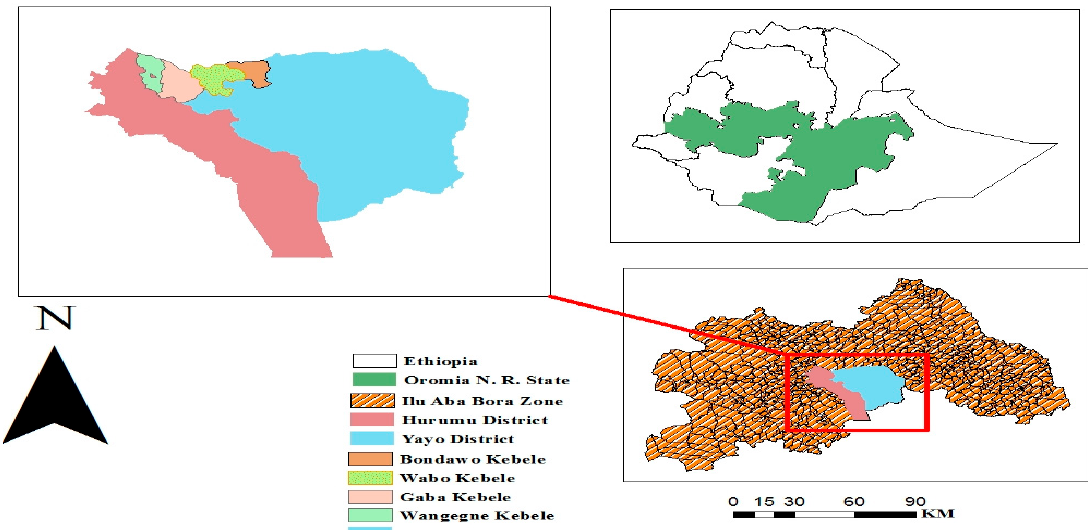
Figure 1. Map and location of study site, July 2017.